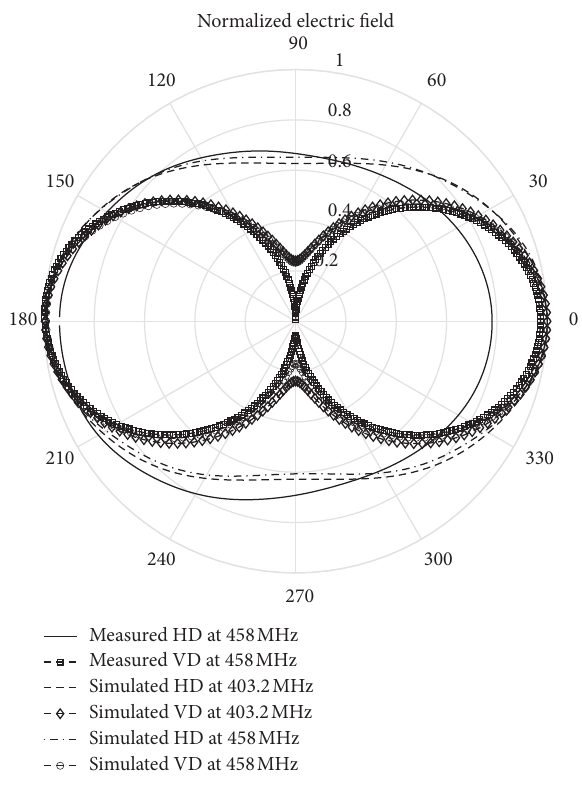
Figure 6: Comparison of normalized electric field radiation pat- terns obtained through simulations and measurements for the FR4- G10 substrate where angles are in